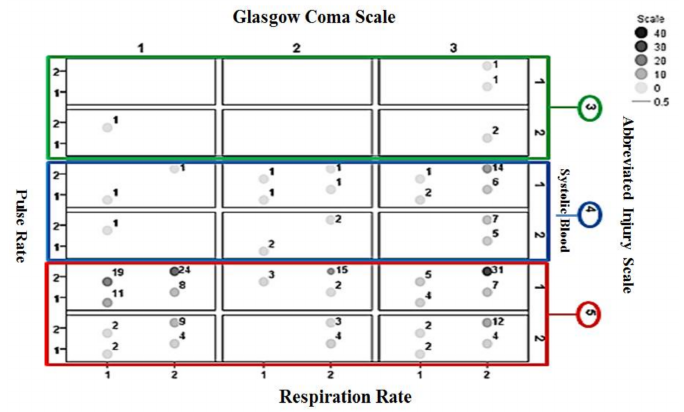
Figure 6. The interrelationships between injury parameters for non-surviving cases. The values next to the circles indicate the number of associated cases. Larger values are highlighted by darker circles. Subjects are from the validation dataset.